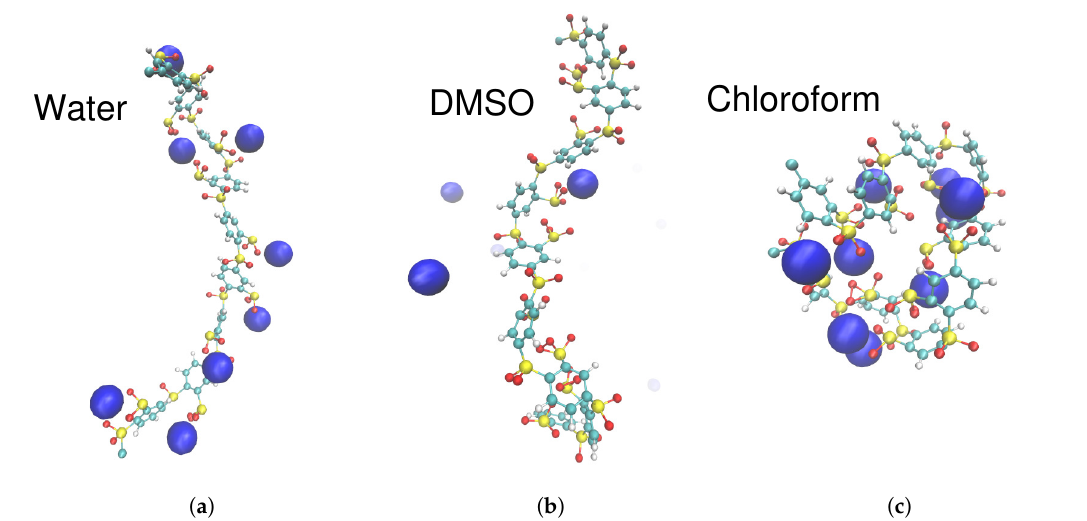
Figure 6. Simulation snapshots of sulfonated oligosulfonic acids with sodium counterions (blue spheres) in: water ( a ); dimethyl sulfoxide (DMSO) ( b ); and chloroform ( c ). With regard to